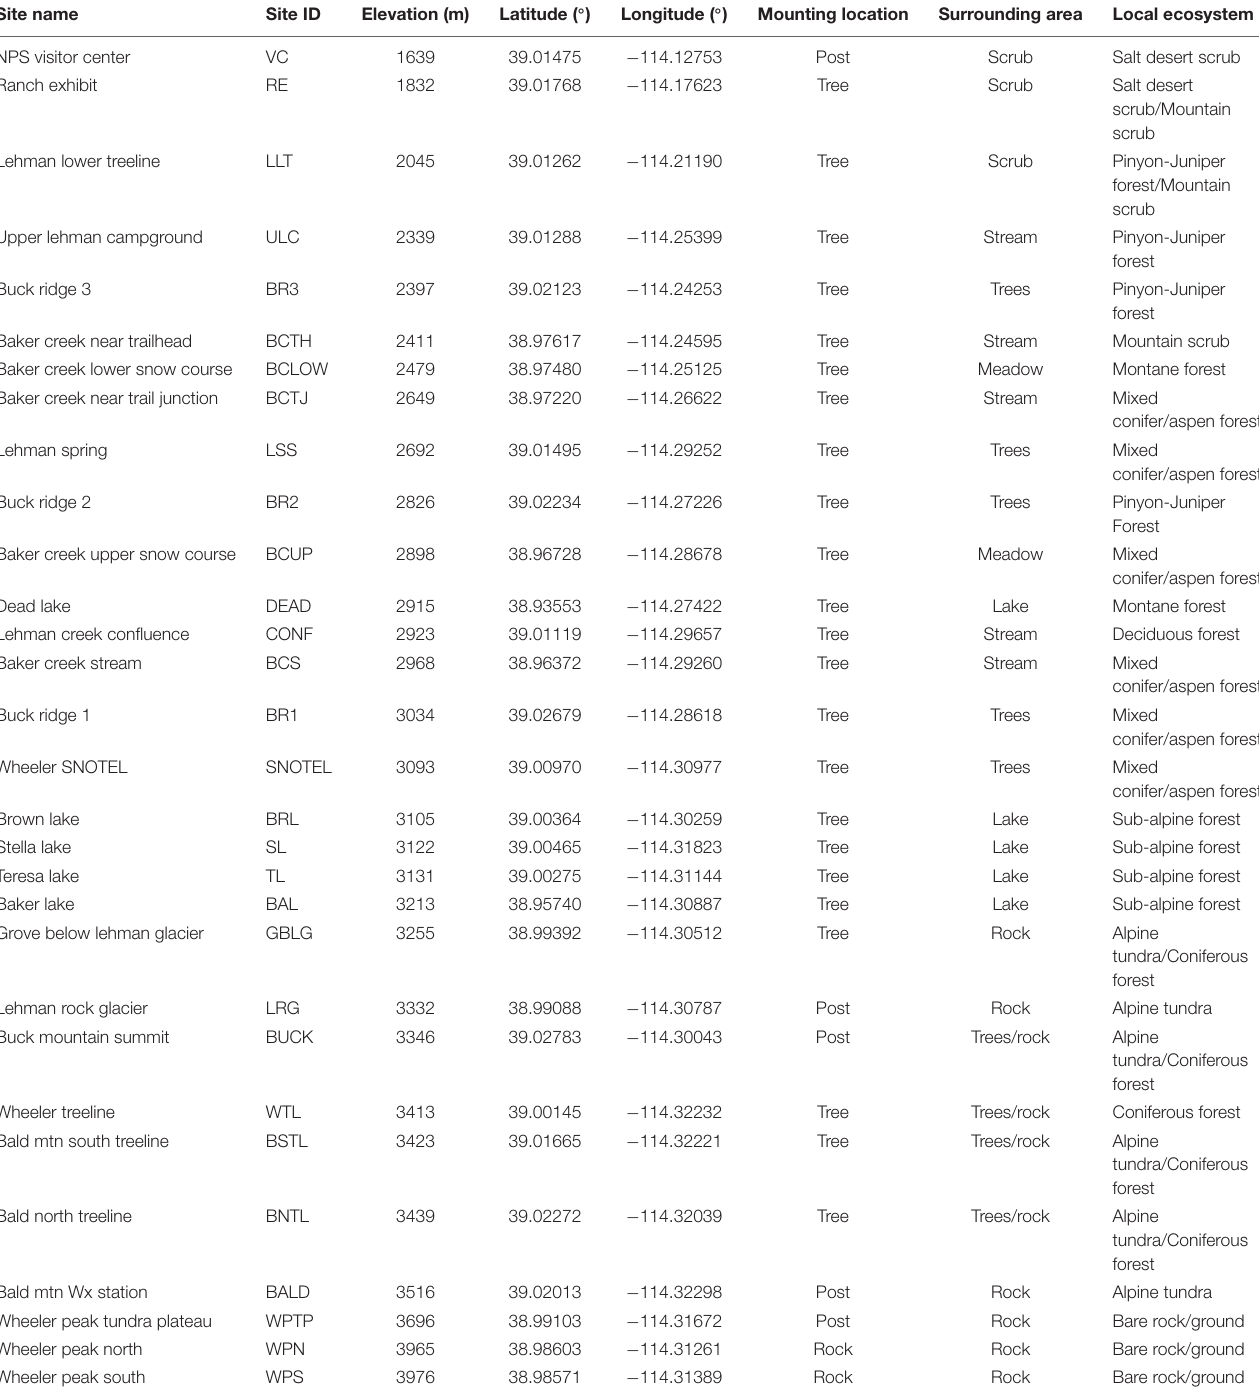
TABLE 1 | Sensor Information table, including site name, site ID, elevation, coordinates, mounting location, surrounding area, and local ecosystem type corresponding to Figures 1 , 2